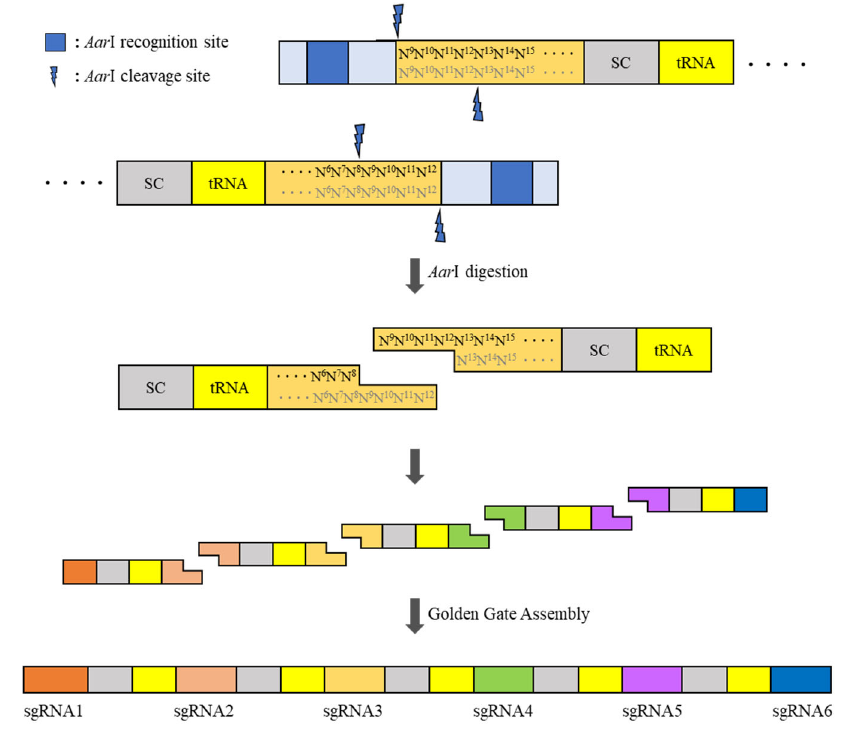
Figure 3. Schematic strategy of the construction of the pBAtC_tRNA vector-based multi-sgRNA insert.